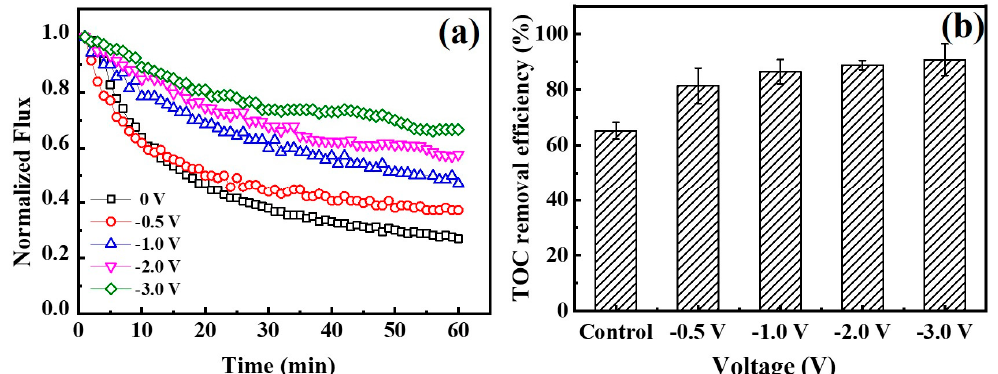
Figure 9. ( a ) Normalized fluxes through a Car-PES membrane at different voltages applied. ( b ) TOC removal efficiency for a Car-PES membrane at different voltages (conditions: (BSA) in = 10 mg/L, (SA) in = 10 mg/L, (yeast) in = 10 mg/L, (emulsified oil) in = 10 mg/L, (Na 2 SO 4 ) = 10 mM, (cross-flow velocity) = 6.1 cm/s and (pressure) = 0.1 bar).